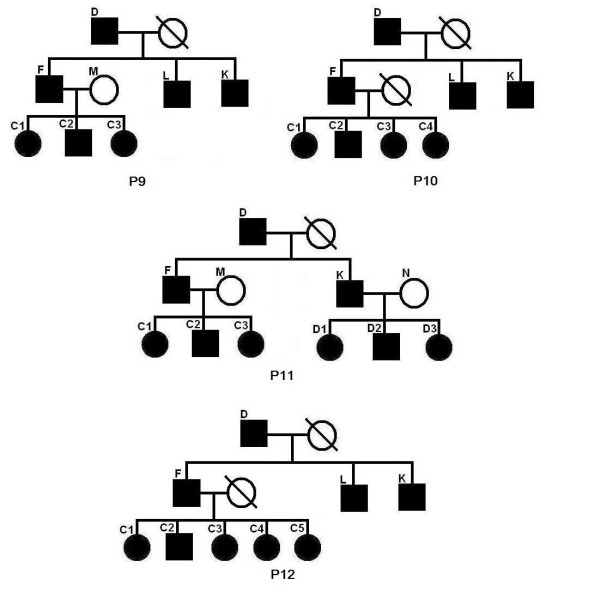
Pedigrees P9 to P12.